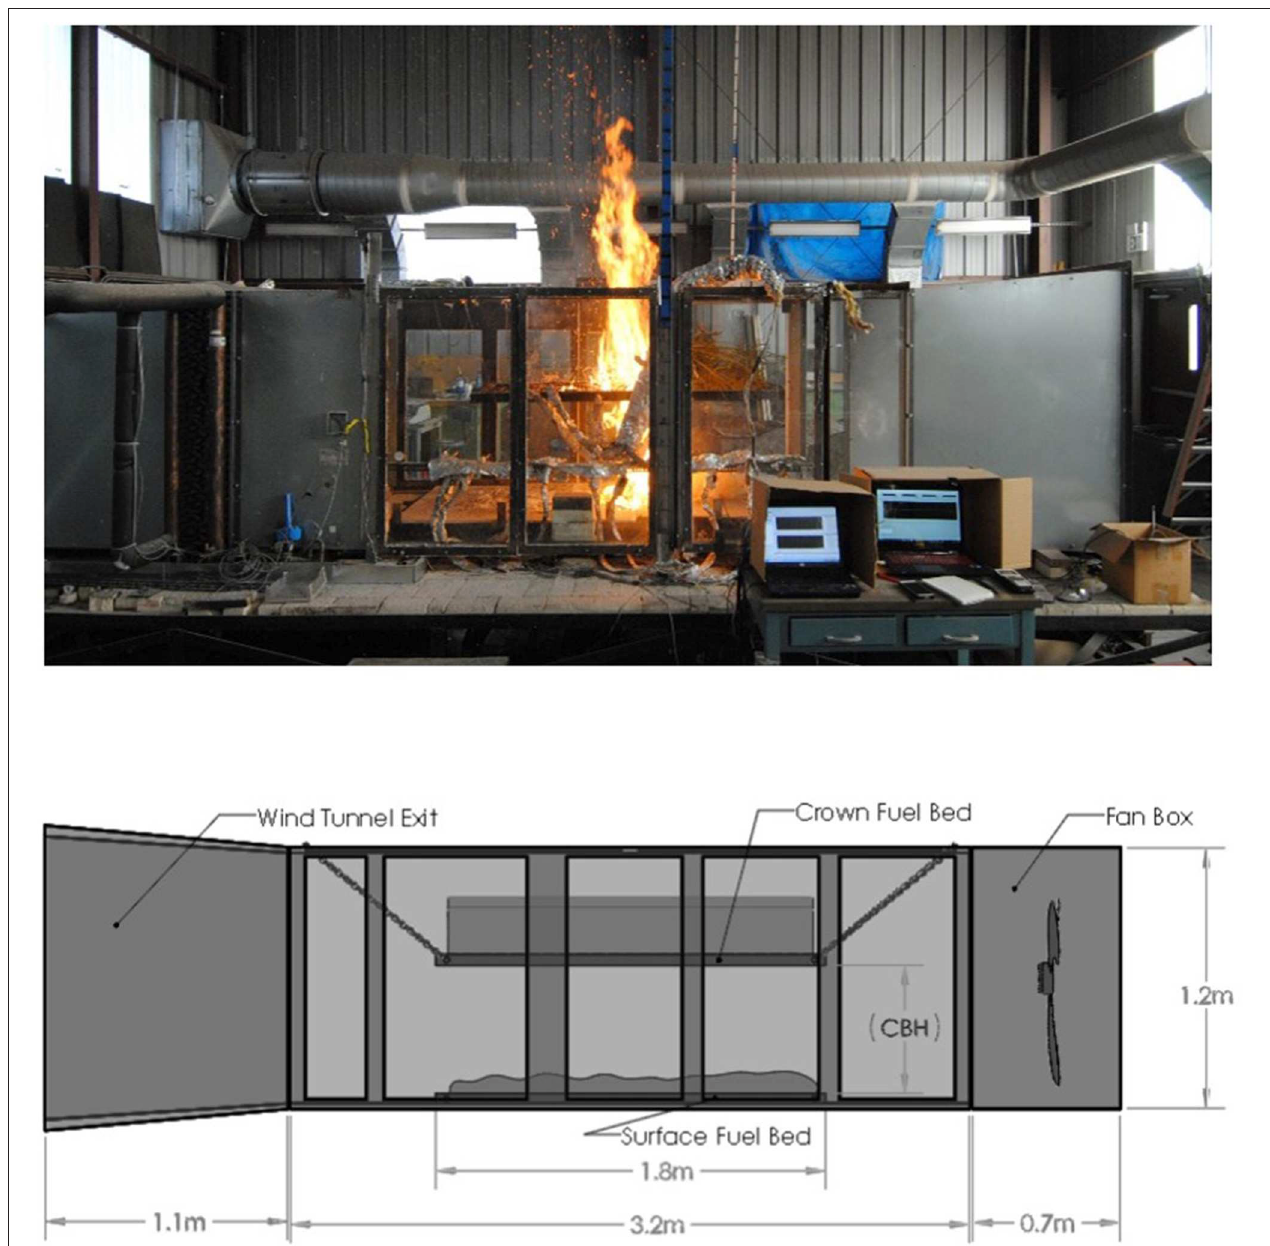
FIGURE 1 | Photograph with wind tunnel configuration with crown base height ( CBH ), flame height ( H ) and experimental configuration labels (top). Schematic of wind tunnel with major dimensions labeled (bottom).